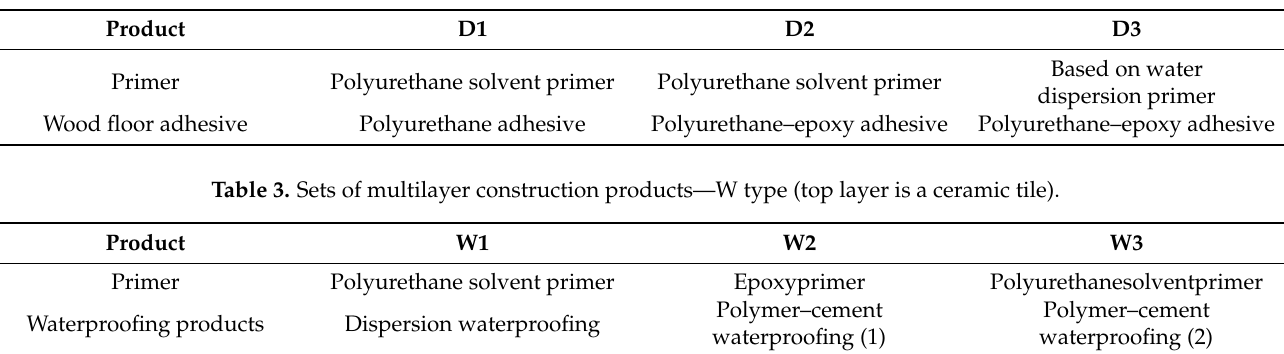
Table 2. Sets of multilayer construction products—D type (top layer is wooden oak parquet).